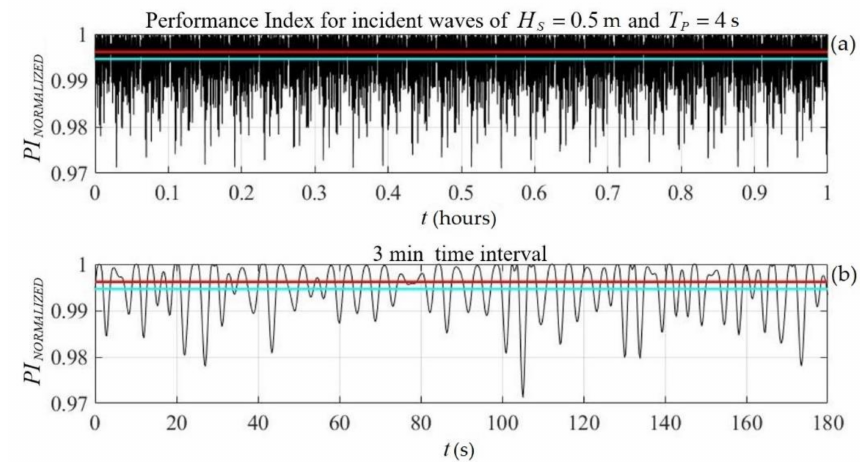
Figure 11. Performance Index of FPV on the floating twin hull structure of breadth B ( T ) = 20 m at a depth h = 30 m in the case of incident waves with a significant wave height H S = 0.5 m and a peak period T P = 4 s. Roll motion time series ( a ) in a 1 h long time interval and ( b ) in an indicative 3 min long time interval.